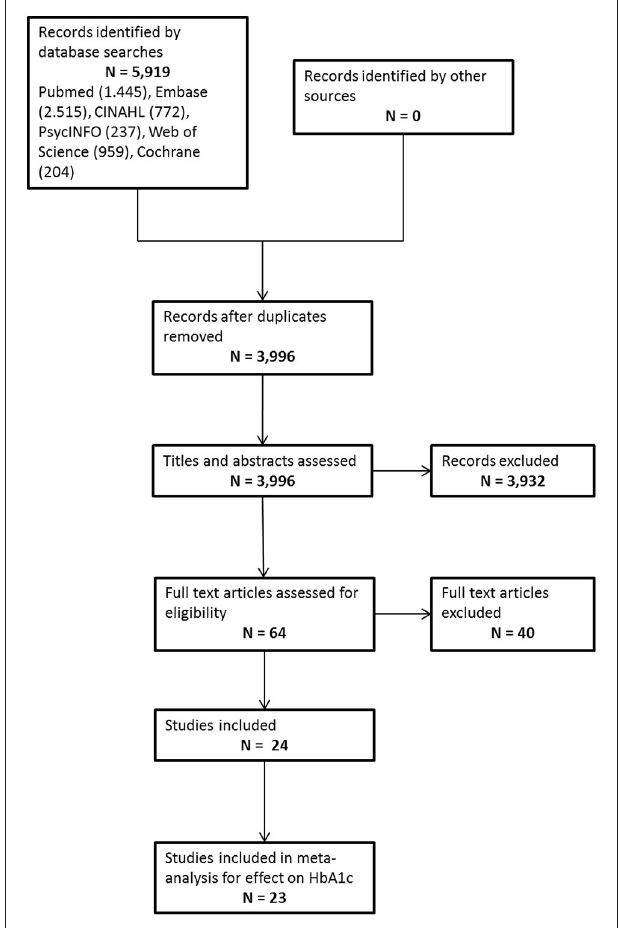
FIGURE 1 | Flow chart study